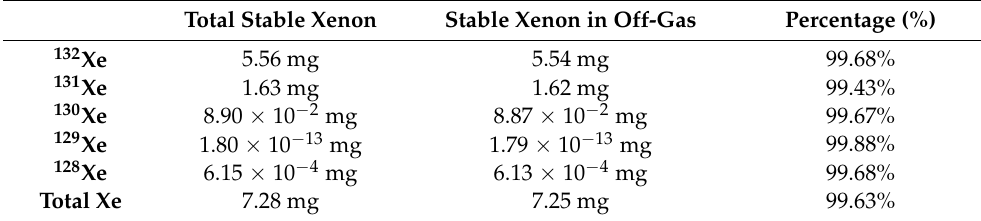
Table 4. Stable xenon accumulations after 1 ATR